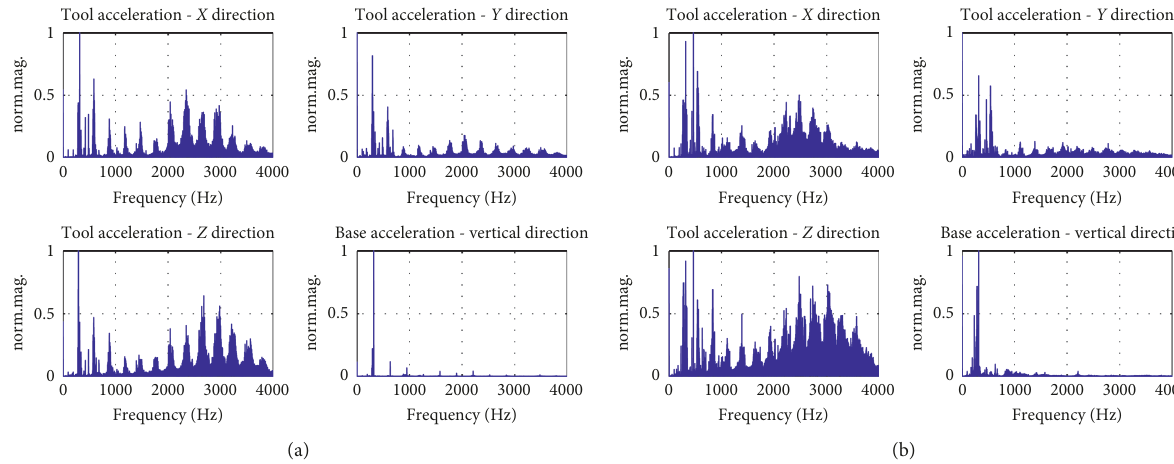
Figure 3: Spectral composition of acquired acceleration (normalized magnitudes) for the case of squared shape (a) and circular shape (b).